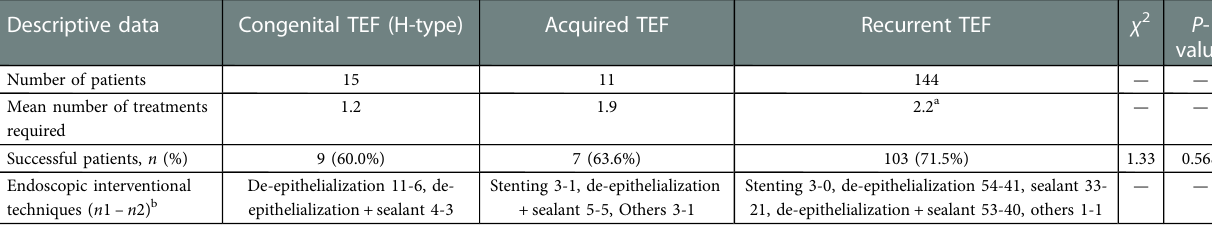
TABLE 2 Summary of results comparing different types of tracheoesophageal fi stula. Descriptive